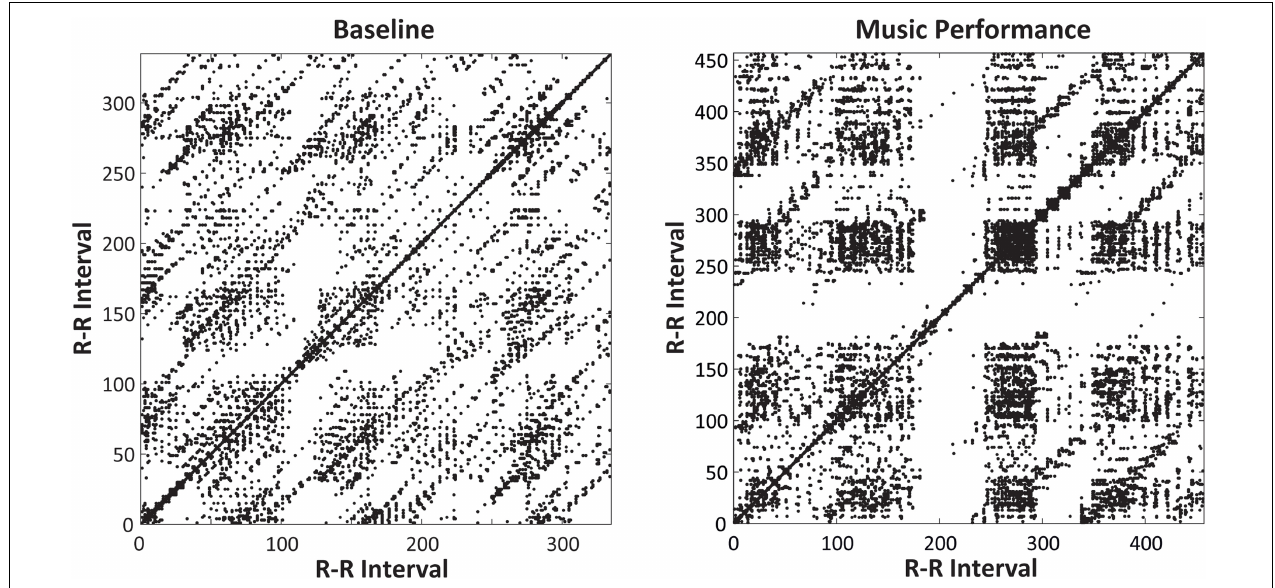
FIGURE 8 | Recurrence plots for a single participant’s heartbeat series (RR intervals, in ms, plotted on x - and y -axes) at 09 h. Plots include Baseline rest (left) and Unfamiliar melody performance (right) . The Melody performance showed greater Laminarity (=51.6%) than did the Baseline Rest (=